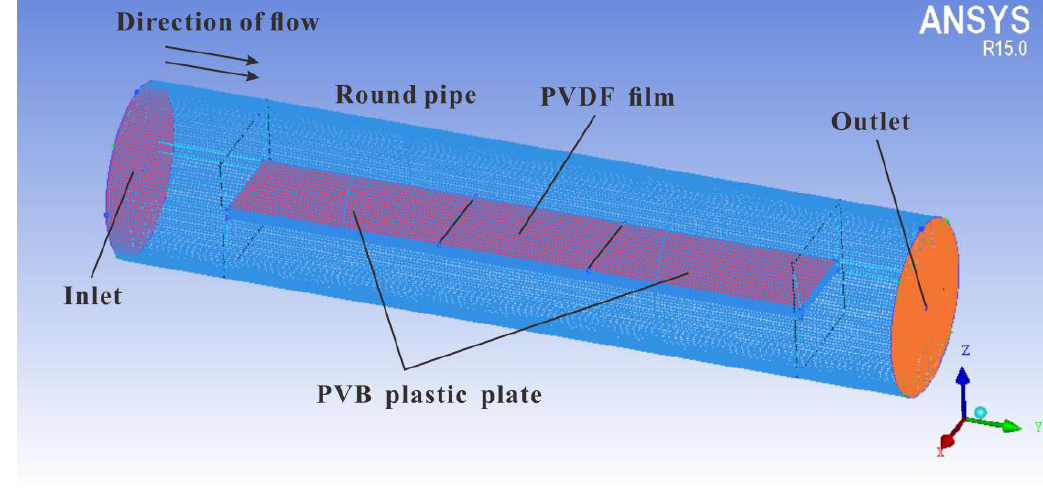
Figure 3. Modeling and meshing of fluid domain.